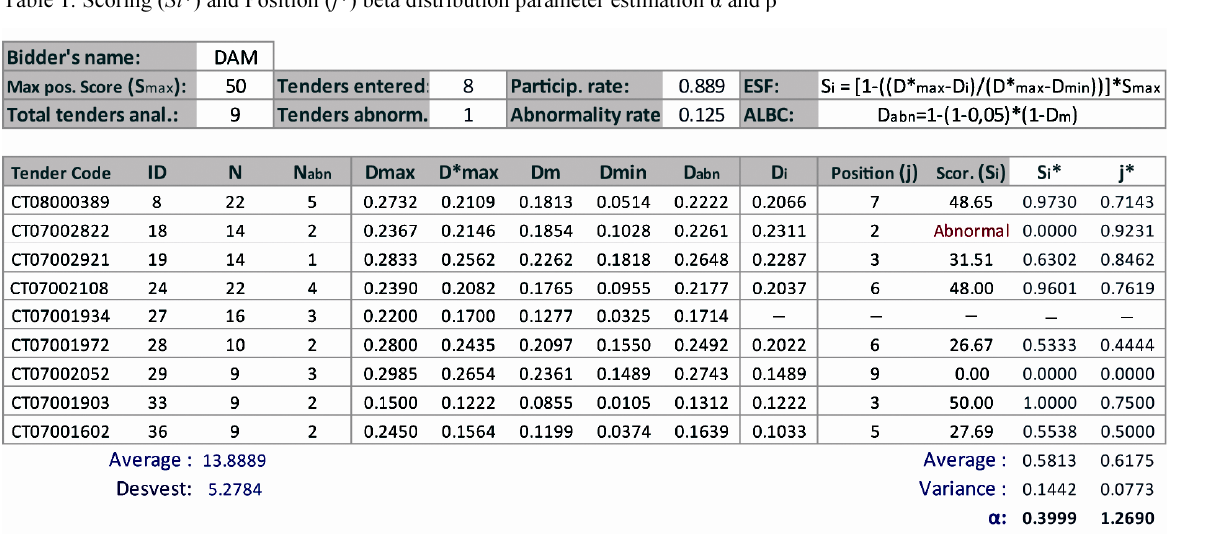
Table 1. Scoring ( Si *) and Position ( j *) beta distribution parameter estimation α and